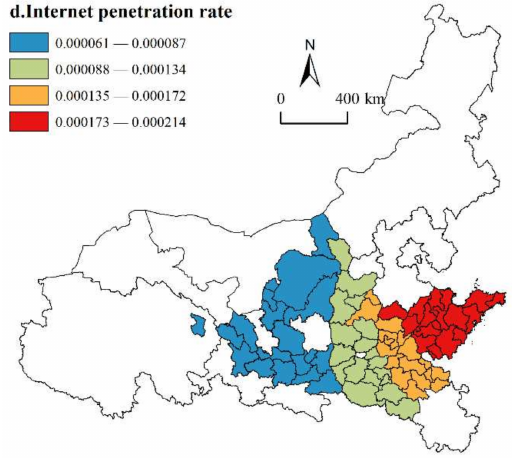
Figure 10. Spatial distribution of internet penetration